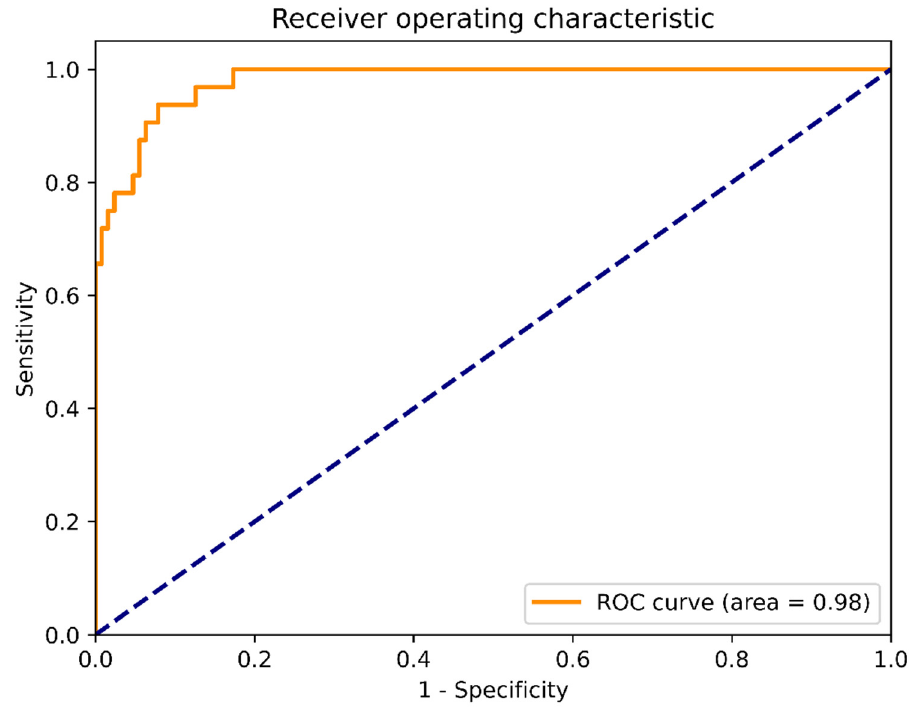
Figure 3. Receiver operating characteristic curve (ROC). The area under the curve (AUC) was far exceeding 0.9, which indicated that the proposed system was able to accurately assess adenoid